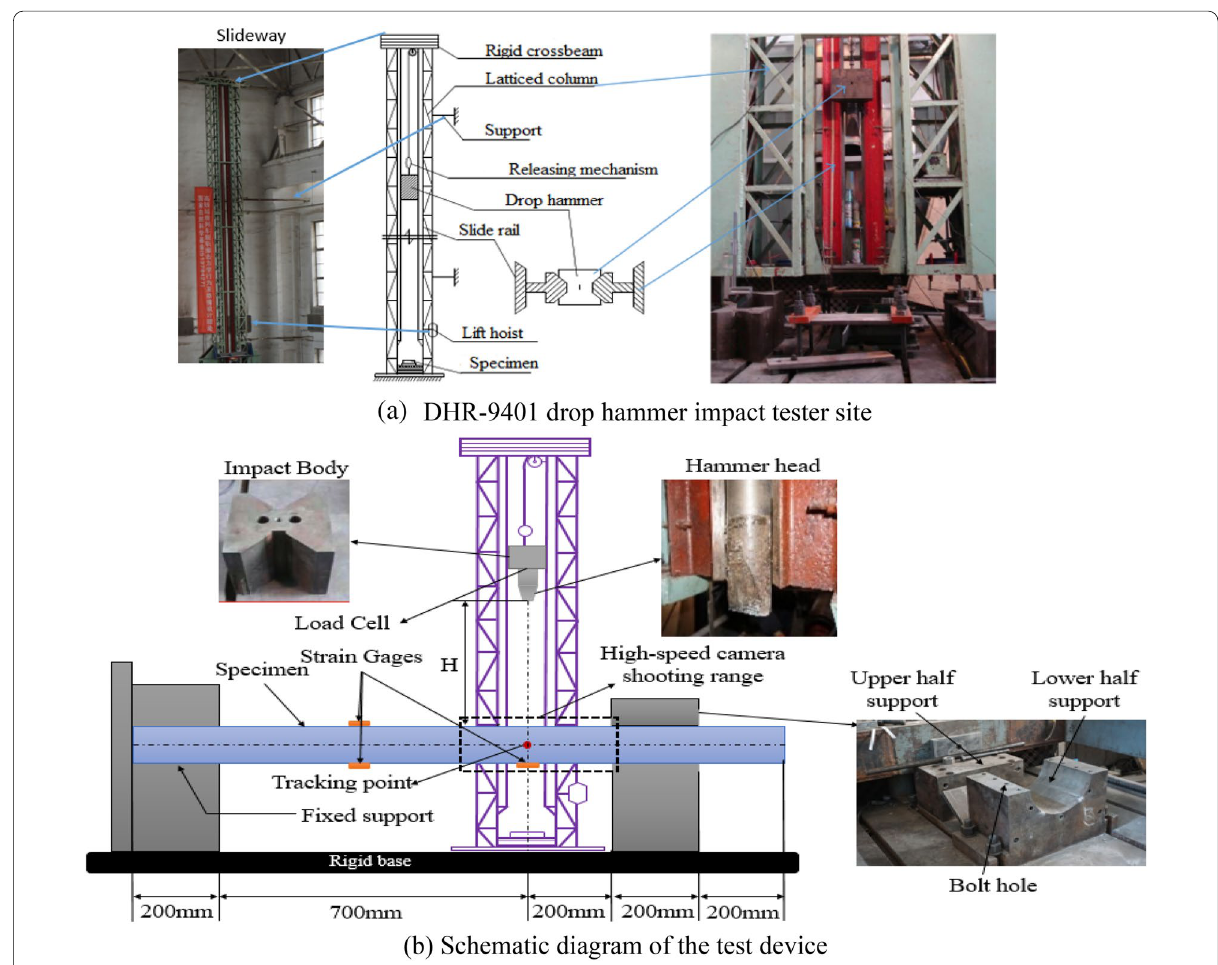
Fig. 3 DHR9401 drop hammer impact tester test